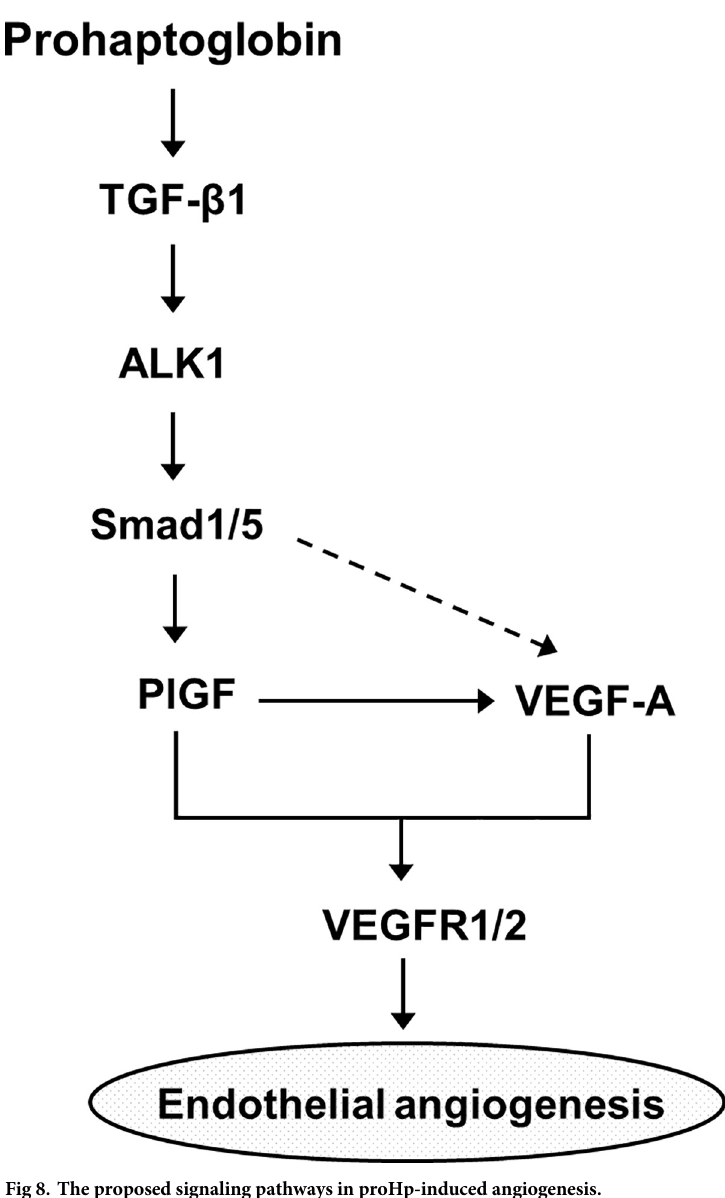
Fig 8. The proposed signaling pathways in proHp-induced